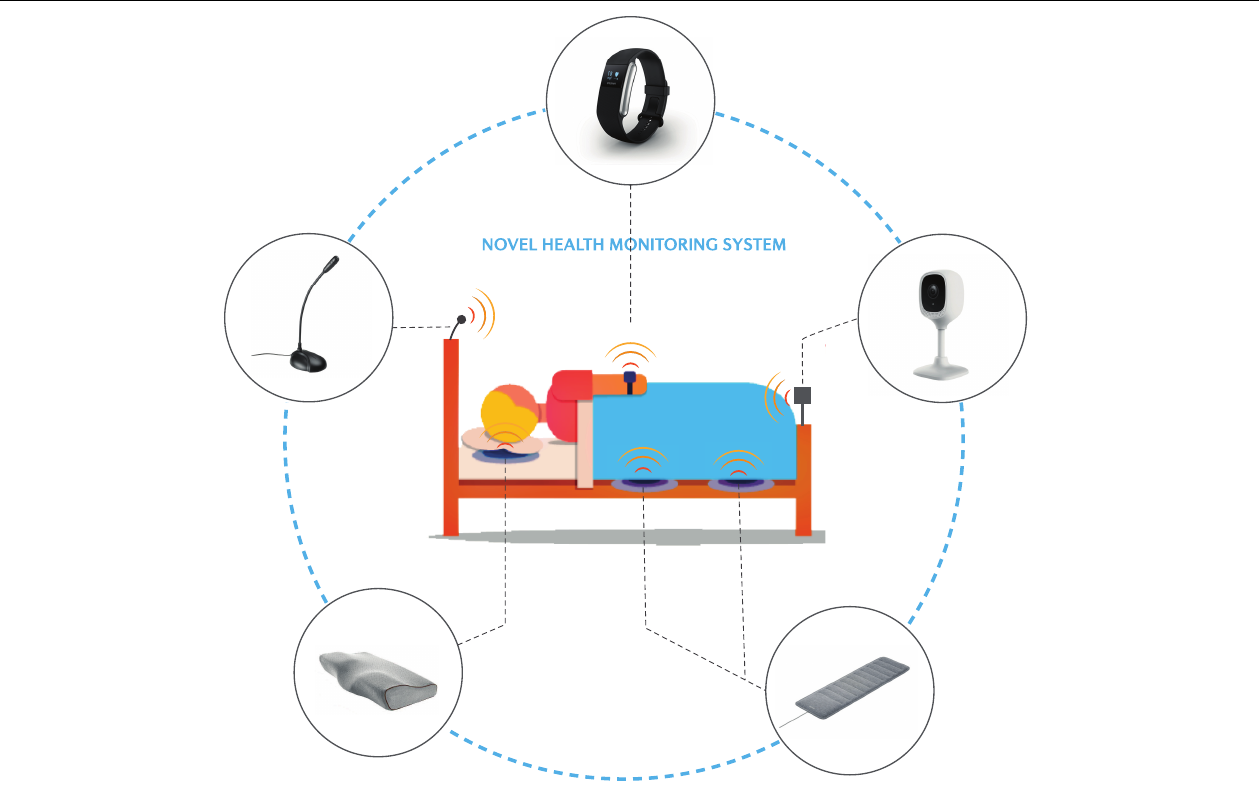
FIGURE 6 | Schematic of novel and emerging approaches to monitor the sleeping environment and track key health measures via “the bedroom of the future.” Refer to the text for further detail.